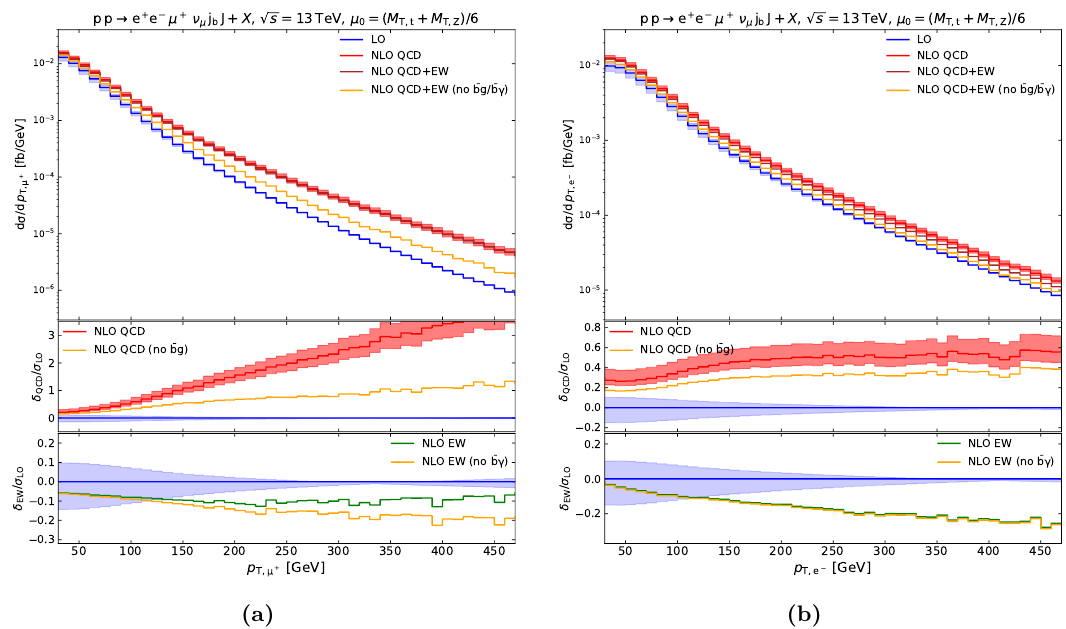
Figure 8. Transverse-momentum distributions of the anti-muon and the